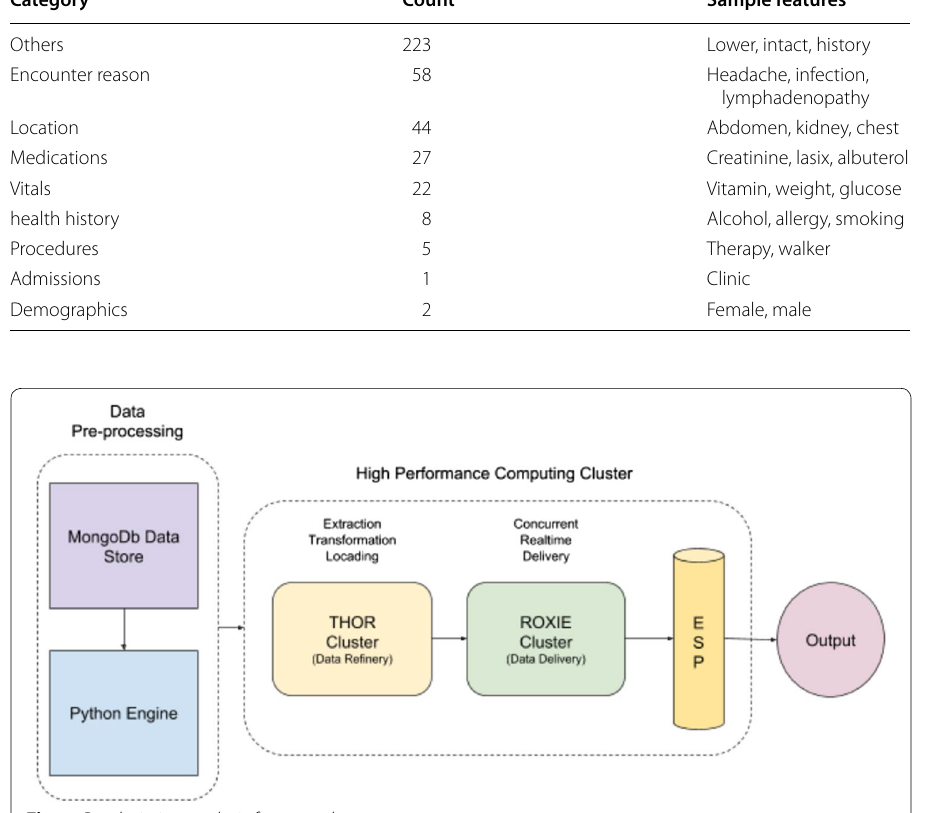
Fig. 4 Readmission analysis